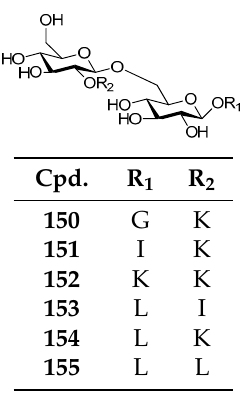
Figure 14. Structure of compound 149 .